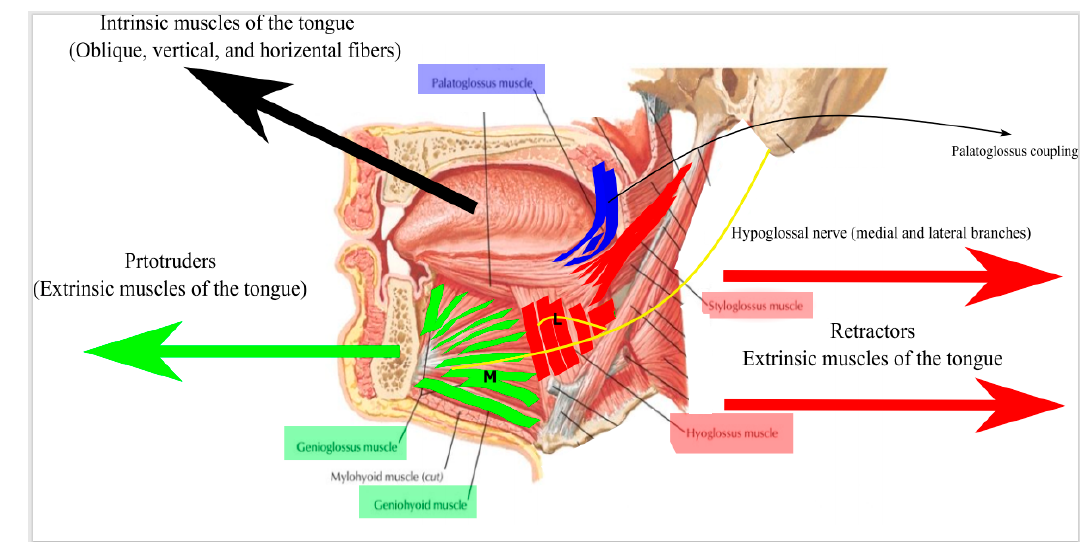
Figure 10. A sagittal section in the head showing the intrinsic and extrinsic muscles of the tongue and their role in the protrusion and retraction of the tongue in addition to the opening of the retropalatal and hypopharyngeal space via palatoglossus coupling. (L) and (M) are the lateral and medial branches of the hypoglossal nerve, respectively.